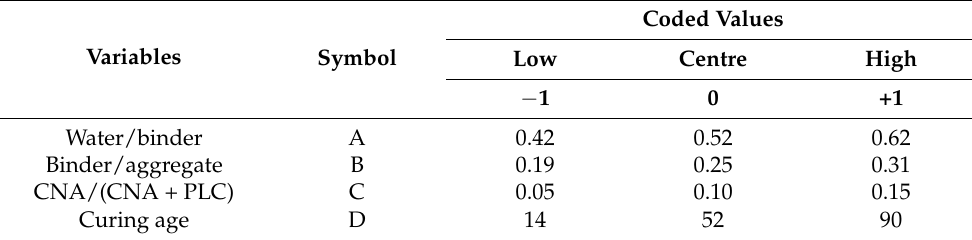
Table 5. Four continuous variables in a three different levels for